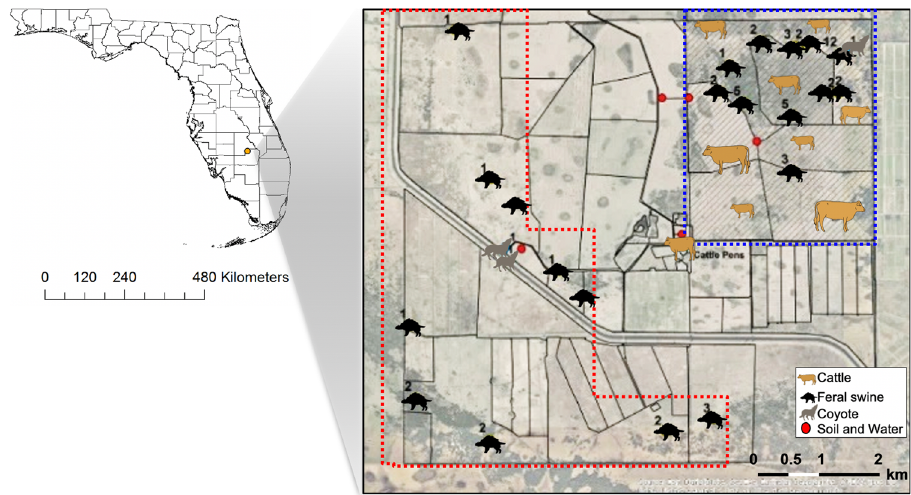
Fig. 1 Location of samples. The samples used in this study were collected from South Florida. Feral swine were divided into ‘ FWCGA ’ (dashed blue line) and ‘ FOCGA ’ (dashed red line) groups based on where samples were collected. Labels represent the number of animals collected at each spot. The county- level map of Florida was acquired through ArcGIS online, created by the EsnTrainingSvc, and the map was visualized using ArcMap